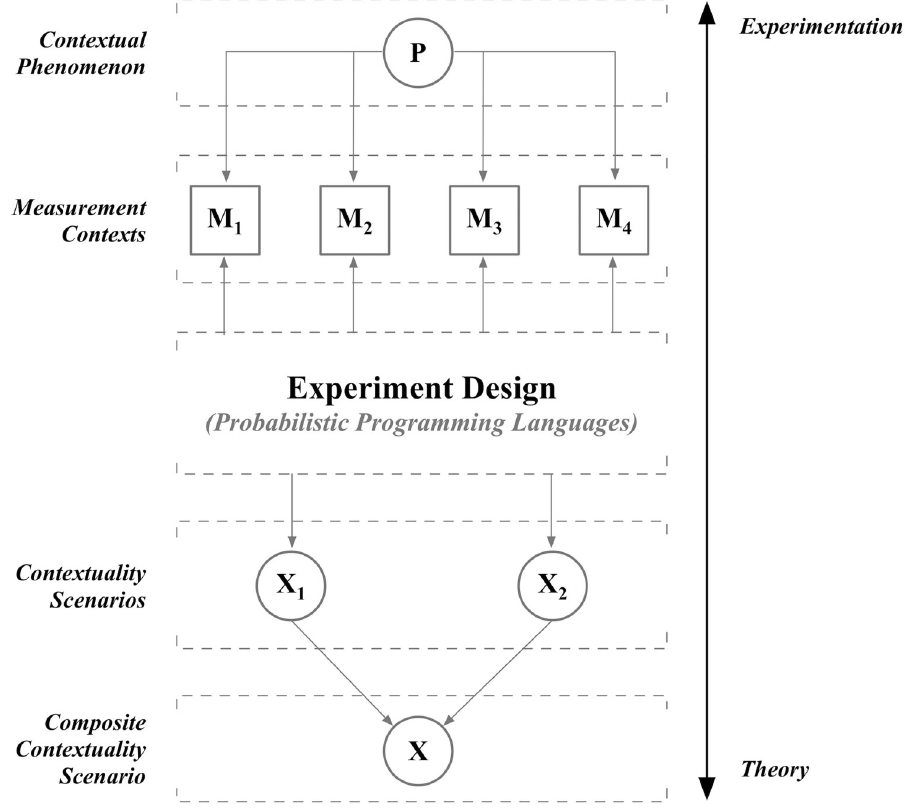
Fig 2. Framework for the EPR